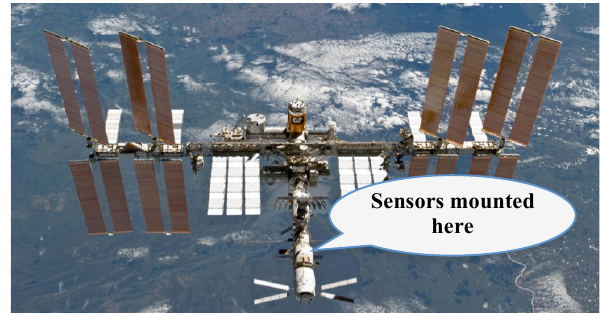
Figure 2. Location of the First-Generation Sensors on the ISS The MRC is a 5m-class pushbroom sensor with a nominal 50km wide swath (at nadir for 400km altitude), which has four spectral channels: blue, green, red and near-infrared (NIR). The MRC is rigidly attached to the ISS in a near nadir-pointing configuration.